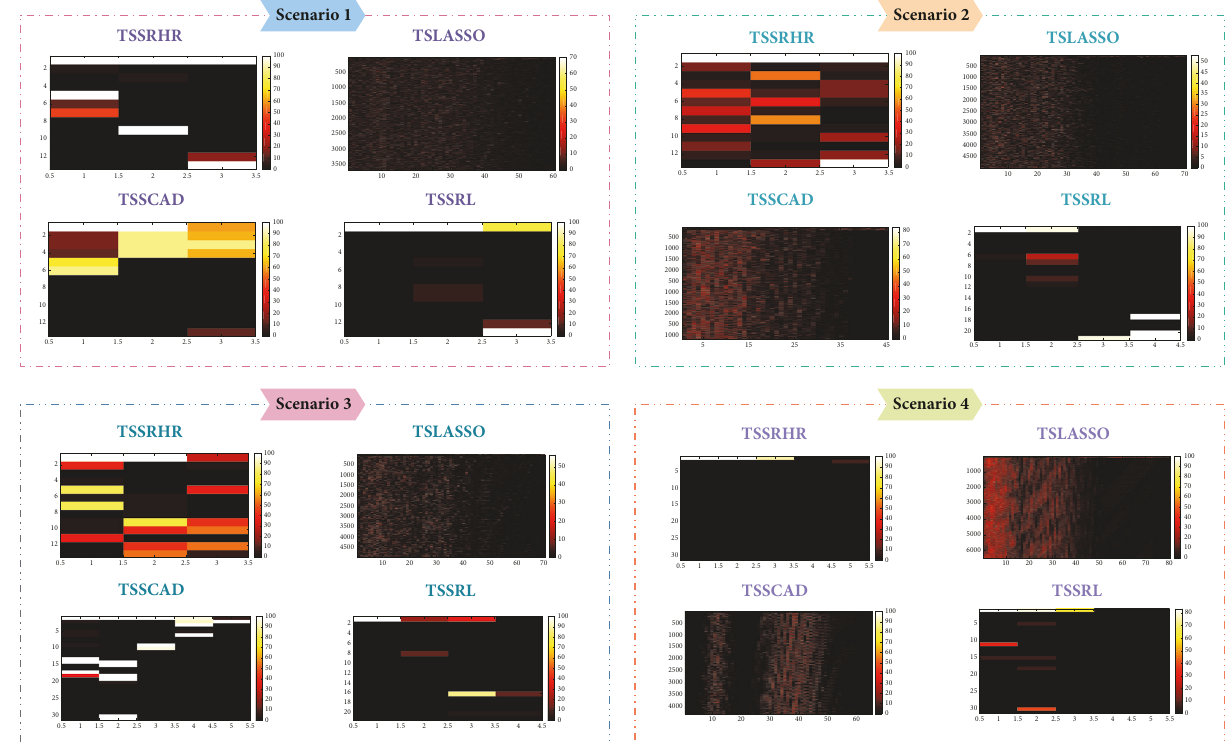
Figure 2: Sparsity pattern of compared forecasting methods in Scenarios 1-4.